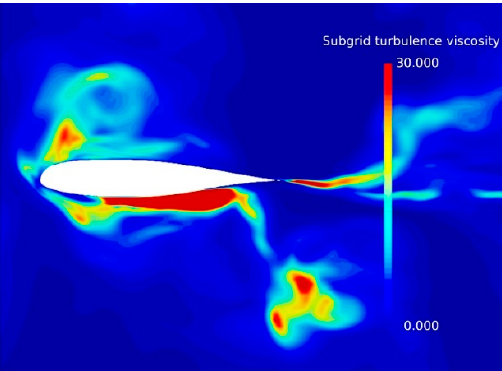
Figure 17. Instantaneous snapshot of normalized eddy viscosity 𝜈 (cid:3047) /𝜈 around airfoil in cylinder wake.